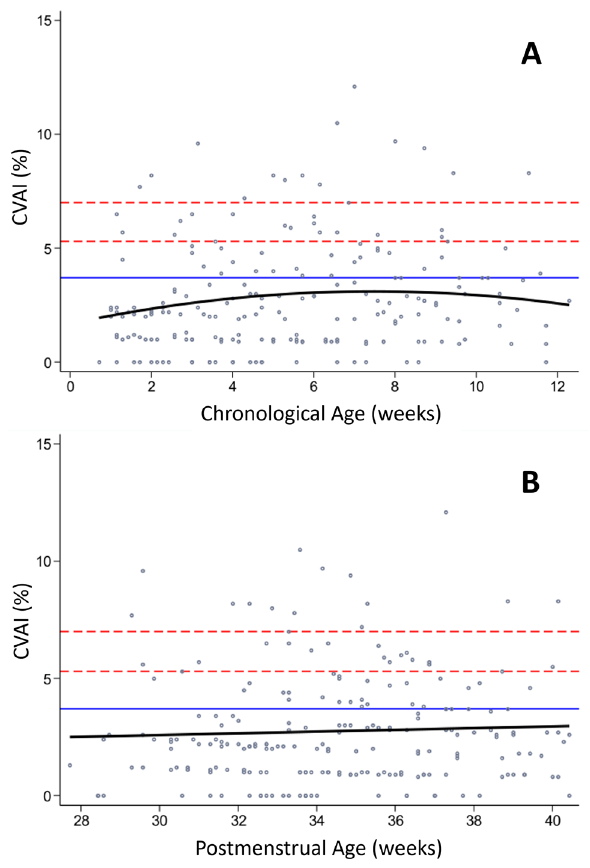
Figure 4. Longitudinal development of plagiocephaly according to chronological ( A ) and postmenstrual age ( B ). Severe plagiocephaly (above upper red bar; cranial vault asymmetry index (CVAI) > 7%), moderate plagiocephaly (between upper and lower red bar; CVAI > 5.3 to 7%), mild plagiocephaly (between lower red and blue bar; CVAI 3.7 to 5.3%), normal cranial vault symmetry (below blue bar; CVAI < 3.7%).